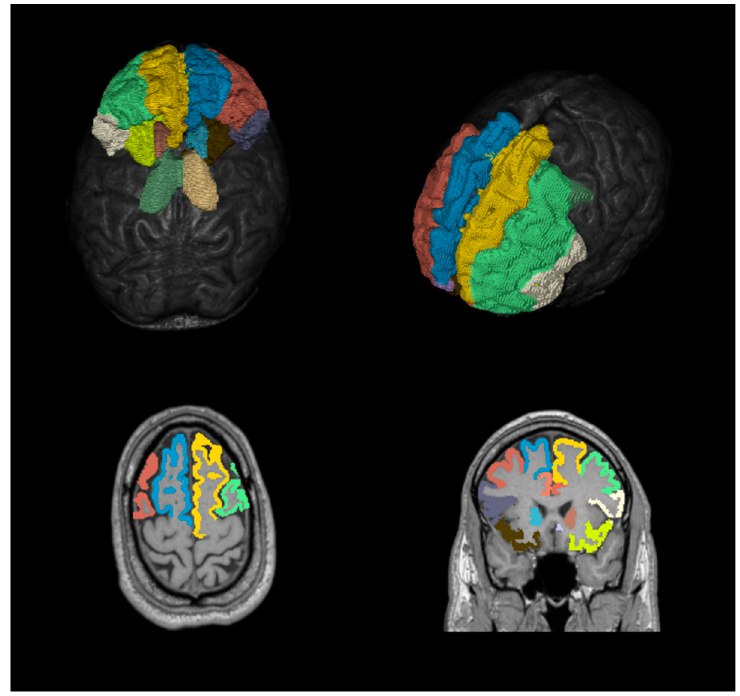
Figure 2. Volumetric reconstruction ( upper ) and segmentation of 3D images ( lower ) enhanced in T1, color map showing the cortical areas and basal ganglia evaluated. Perfusion and BAT quantification. The ASL image was co-registered to the T1 image and the resulting transformation was applied to both CBF and BAT volumes. Mean perfu- sion (mL/100 g/min) and bolus arrival time (ms) were then quantified from the registered CBF and BAT volumes for each ROI of interest (Figure